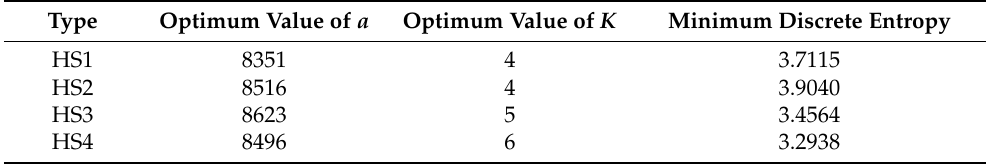
Table 4. Optimization results for a and K .